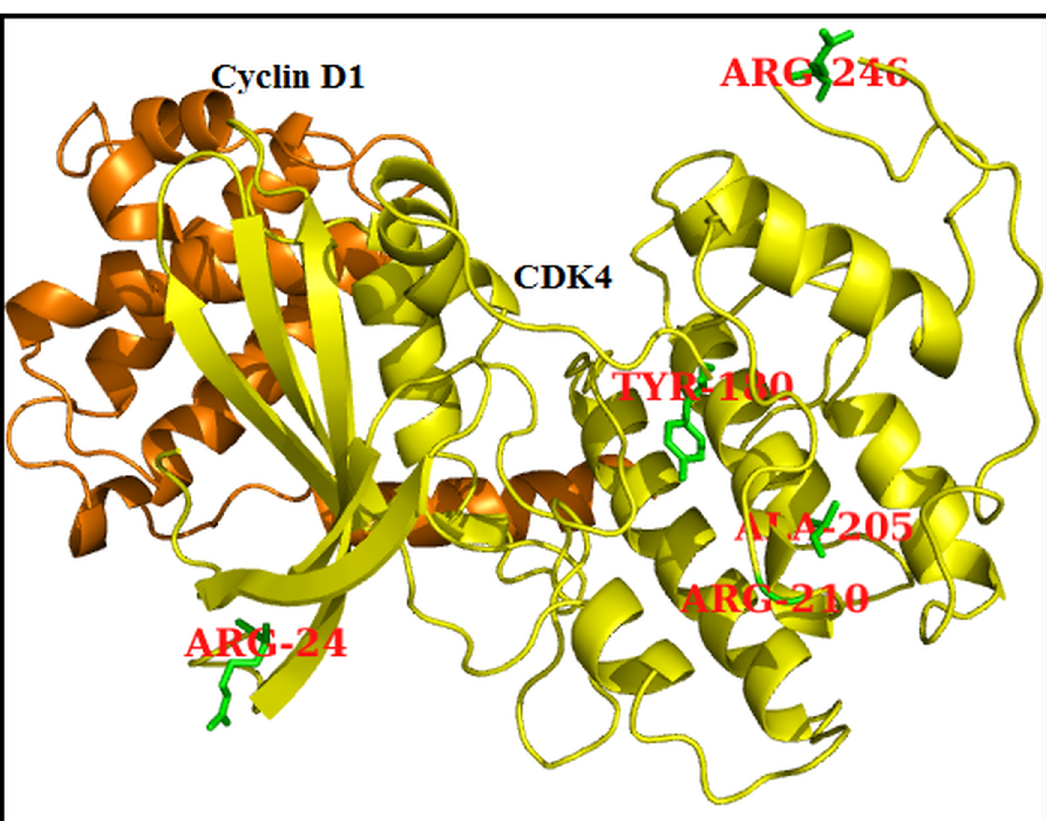
Fig 1. CDK4 (Yellow) in complex with CyclinD1 (Orange) protein and all the five highly deleterious variants are highlighted in stick model (Green